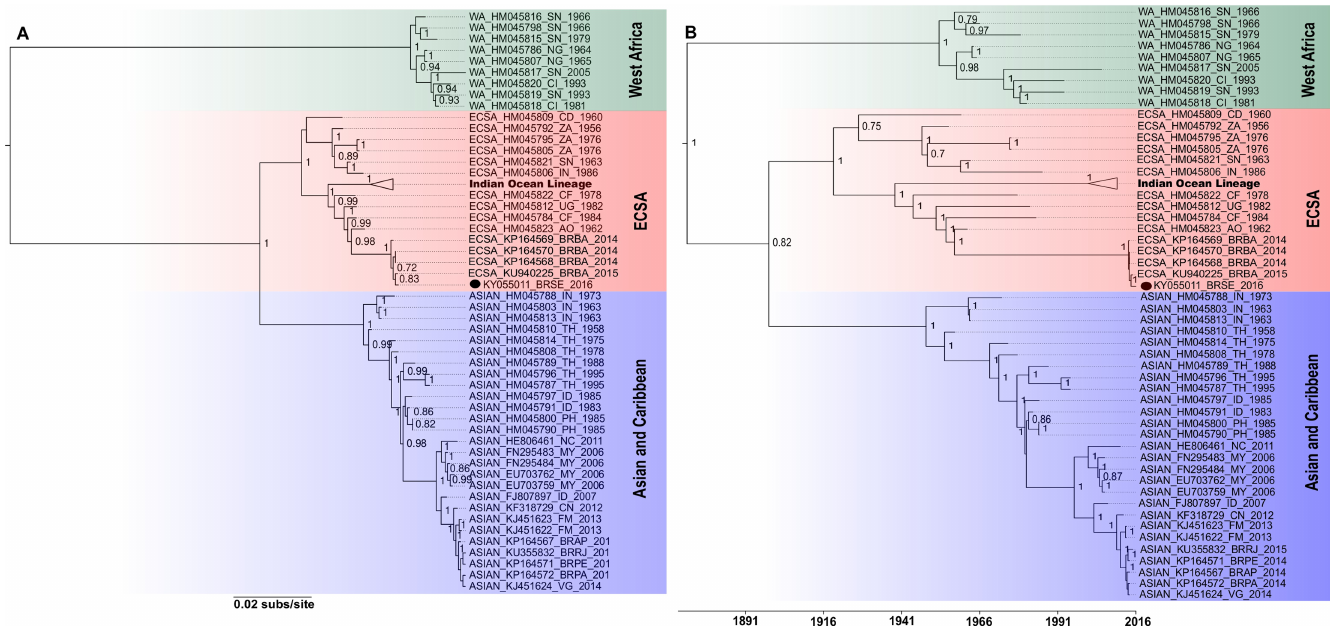
Fig 2. Evolutionary relationship between the three genotypes of CHIKV. A. Maximum likelihoodphylogenetic tree of the CHIKV genomicsequence (KY055011_BRSE_2016) obtained from positive field-caught Ae . aegypti . The numbers on the branches represent the bootstrapvalues. B. Temporal maximum clade credibilitytree of the CHIKV genomicsequence(KY055011_BRSE_2016)obtainedfrom positive field-caught Ae . aegypti .The numberson the branches represent the posterior probabilityvalues.